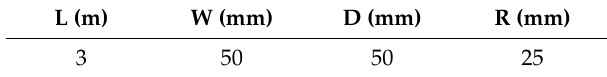
Figure 1. The study case: ( a ) isometric view of the channel with an inner cylinder and with a wavy fin; ( b ) side view. Table 2. Description of the under-study channel, basic dimensions.